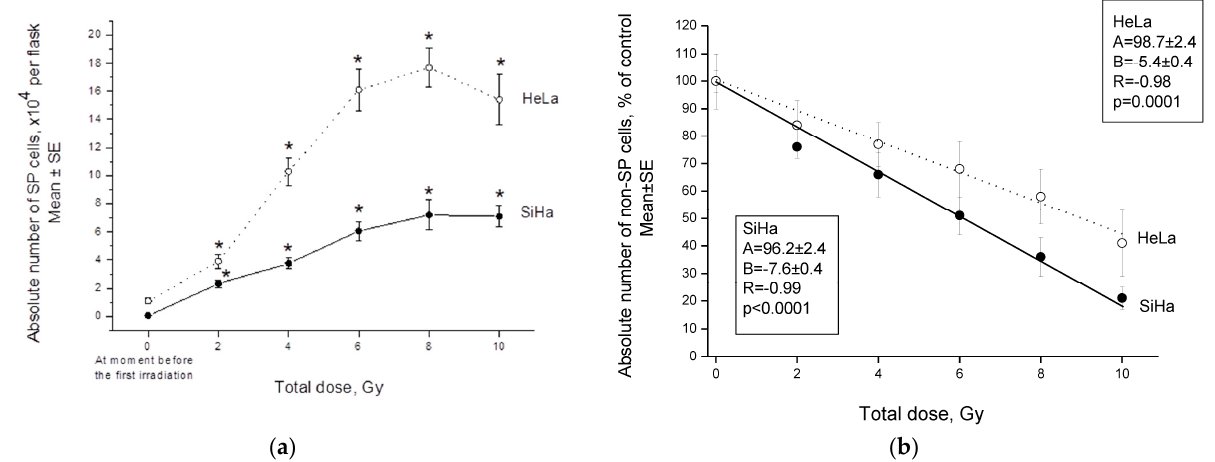
Figure 1. Effects of fractionated γ -radiation exposure on the absolute number of side populations (SP) ( a ) and non-SP cells ( b ) of HeLa and SiHa lines 24 h after the last radiation exposure. The parameters of the linear regressions Y = A + BX are indicated, where X is a total dose (TD) of γ -radiation, Y is the absolute number of non-SP cells of the corresponding cell lines. * p < 0.001 in comparison to the initial level before the first irradiation.